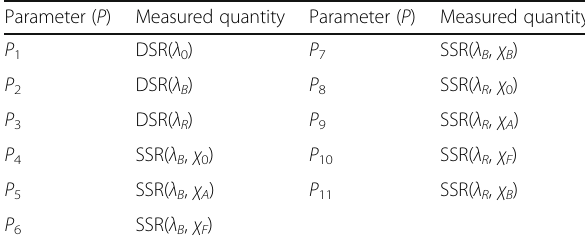
Table 4 Measured quantities ( P 1 – P 11 ) of DSR and SSR for dust retrieval